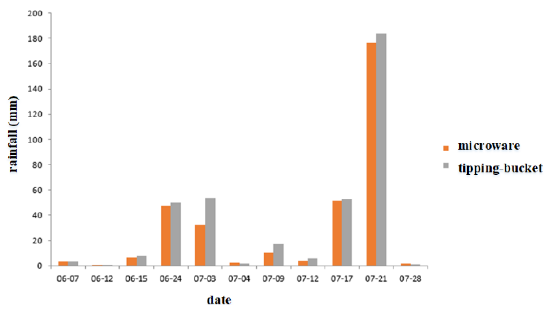
Fig. 3. Applicability test of the microwave rain